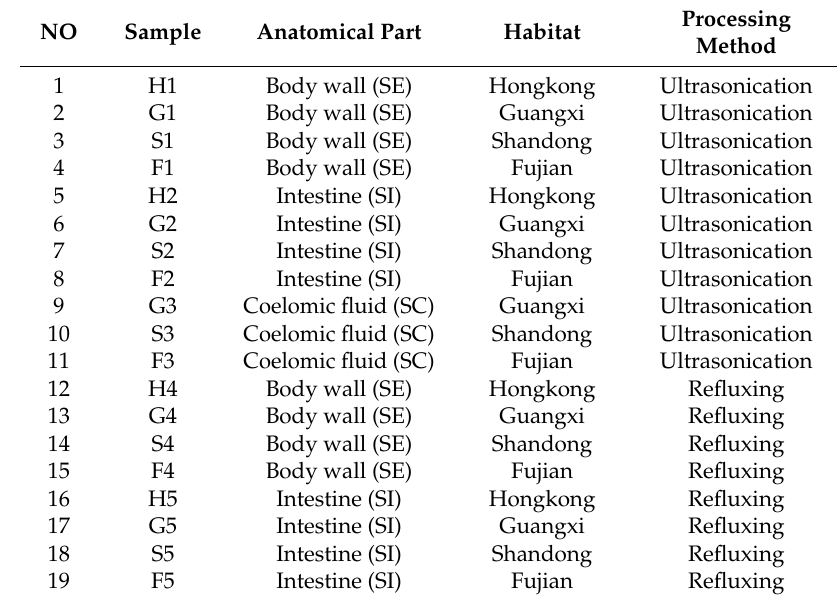
Table 5. Sipunculus nudus